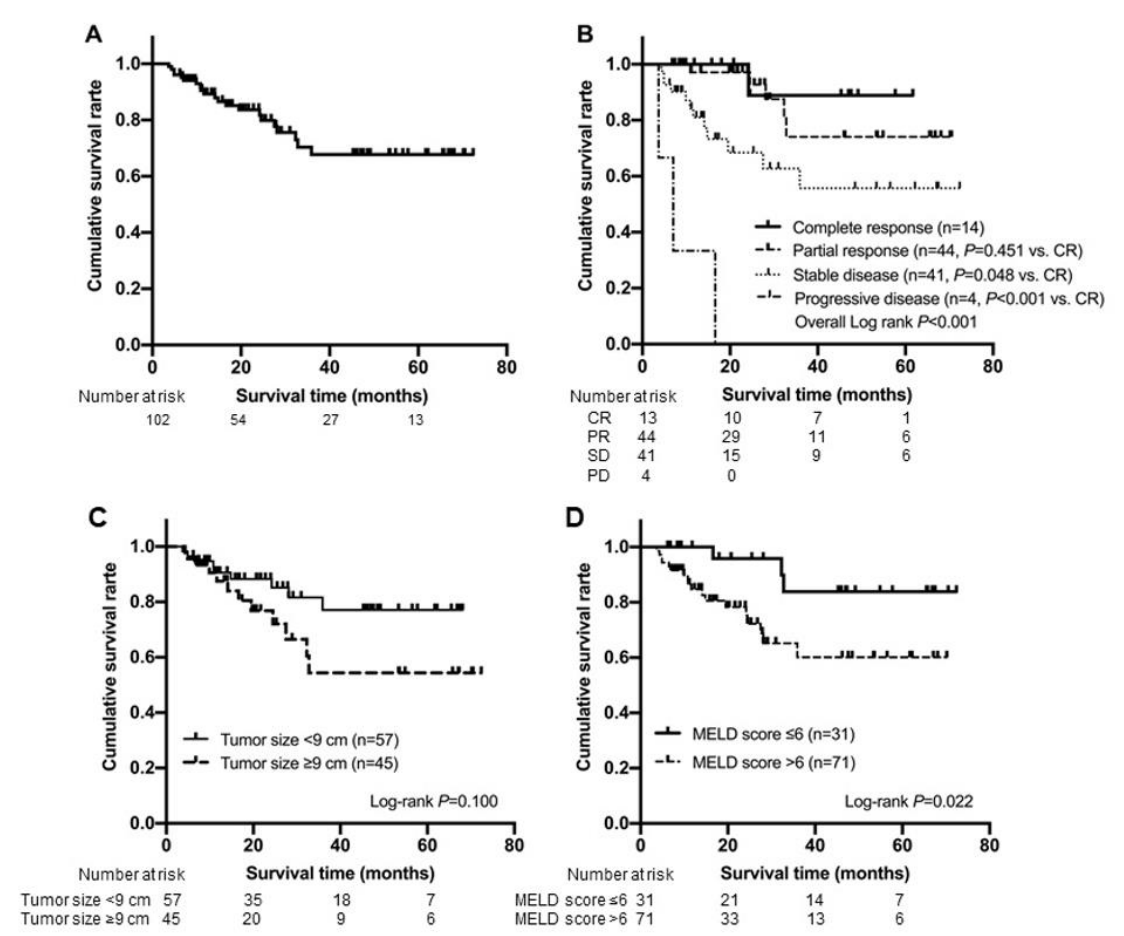
Figure 2. Kaplan-Meier analysis for overall survival of the entire study population ( n = 102) ( A ) and subgroups according to the best response ( B ). Kaplan-Meier curves for overall survival according to tumor size ( C ) and MELD score ( D ), which were the identified predictors for complete response achievement. mRECIST, modified Response Evaluation Criteria in Solid Tumors; CR, complete response; PR, partial response; SD, stable disease; PD, progressive disease; MELD, model for end-stage liver disease.